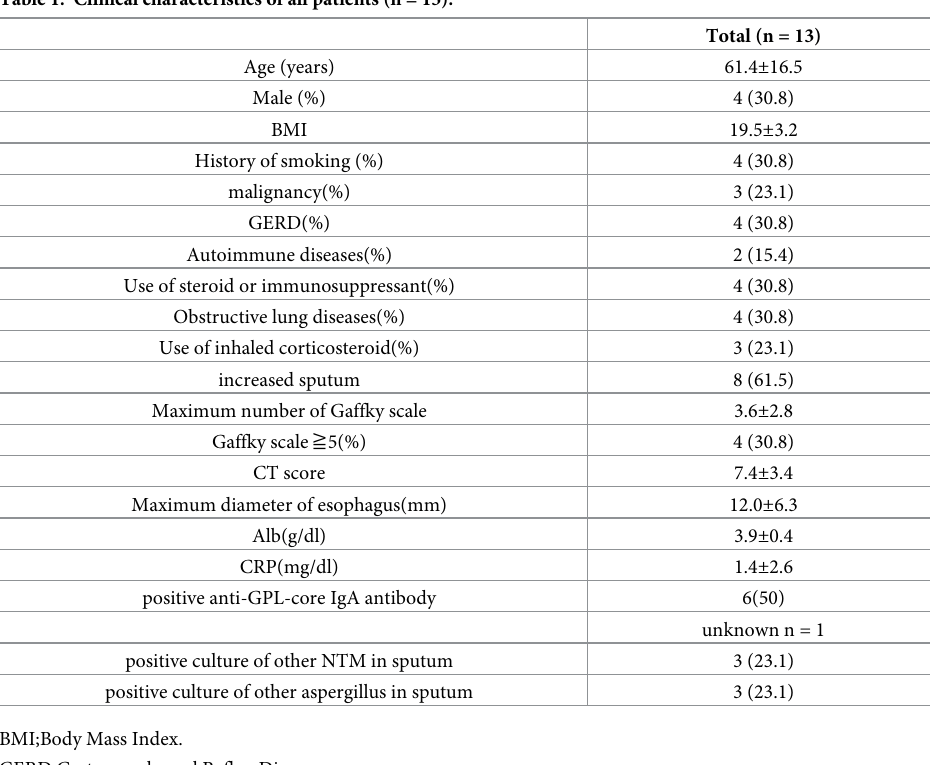
Table 1. Clinical characteristics of all patients (n = 13).